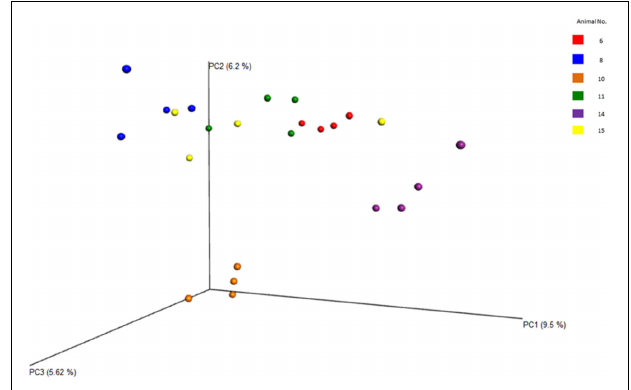
FIGURE 7 | Principal coordinate analysis (PCoA) plots of the diversity among the entire samples and the animals, evaluated from the V4 region. Clearly shows the relatedness/dissimilarities among the samples and among the animals, with the samples from the various animals clustering loosely